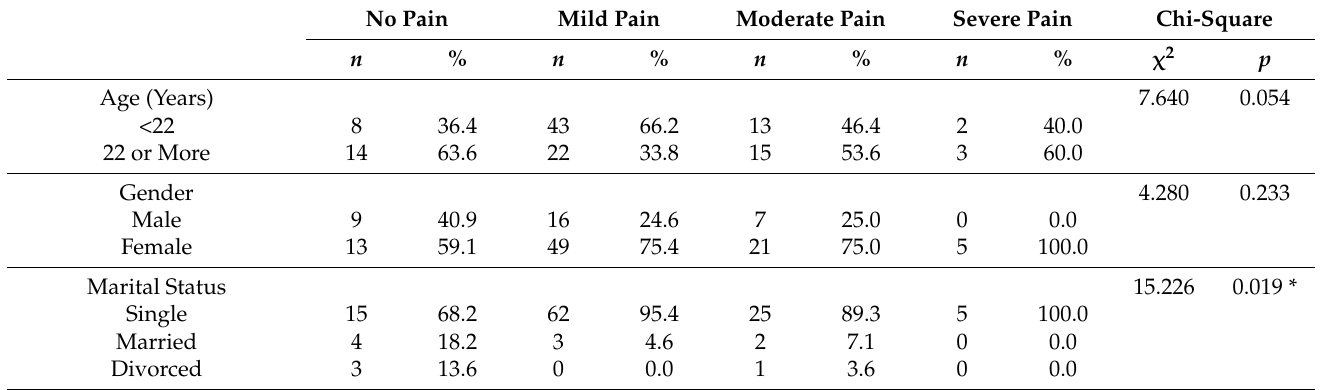
Table 5. Association between the sociodemographic characteristics and Neck Disability Index